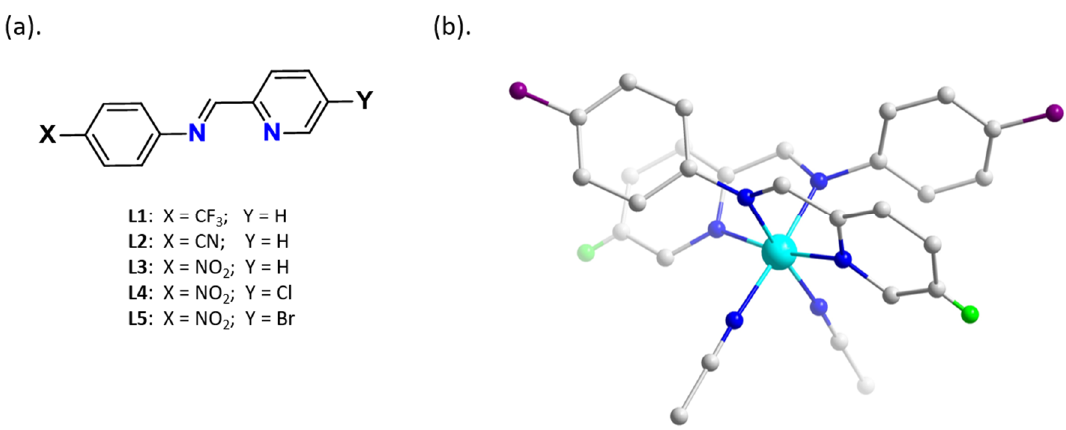
Figure 1. ( a ) Ligands L1 – L5 incorporated into complexes 1 – 5 . Coordinating N-donor atoms are coloured in blue. ( b ) Overall structural arrangement of complexes [Fe(L) 2 (CH 3 CN) 2 ] 2+ ( 1 – 5 ). Atom colouring corresponds to: Cyan (Fe), grey (carbon), blue (nitrogen), purple (X: CF 3 , CN, NO 2 ) and green (Y: H, Cl, Br). Anions, H-atoms and solvent molecules have been omitted for clarity.